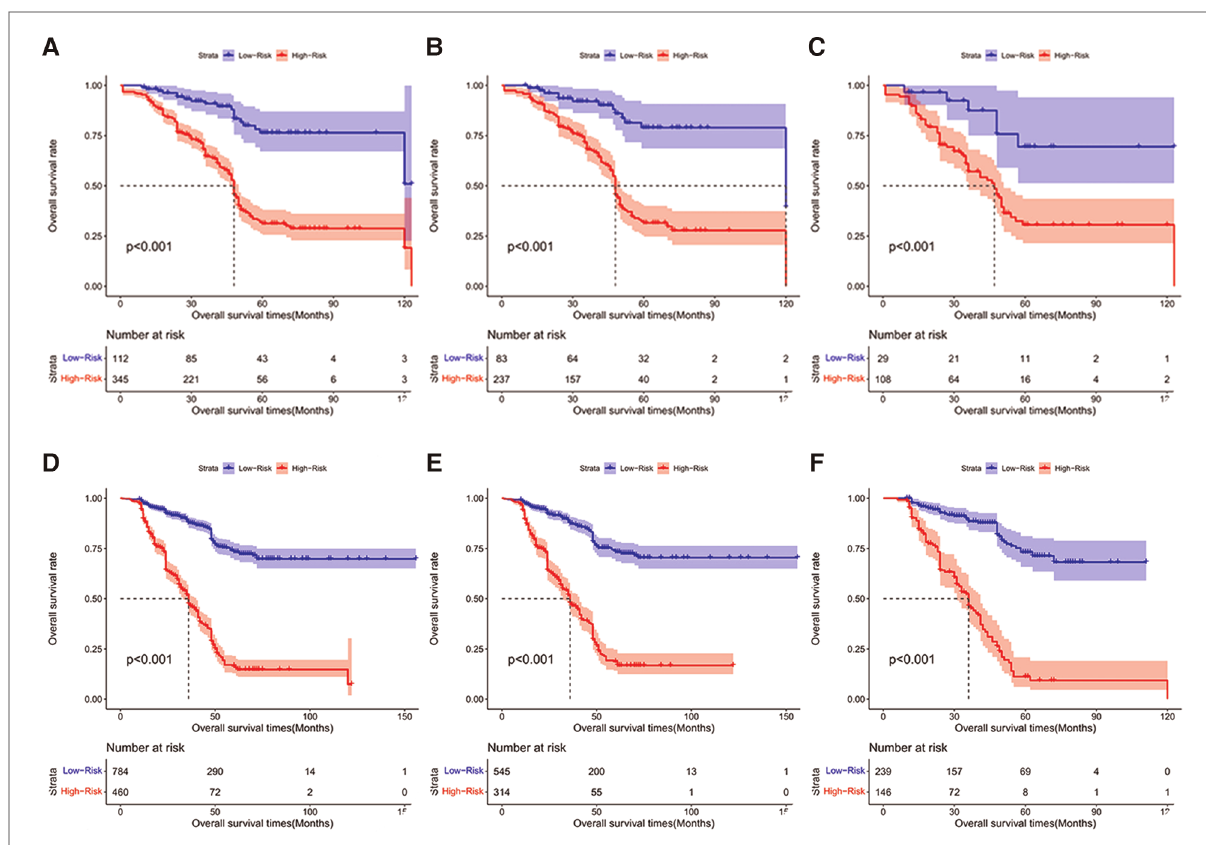
FIGURE 6 The Kaplan-Meier survival curves for patients with different scores who underwent chemotherapy cycles <9. ( A ) all cohort, ( B ) training cohort and ( C ) validation cohort; The Kaplan-Meier survival curves for patients with different scores who underwent chemotherapy cycles ≥ 9. ( D ) all cohort E. training cohort F. validation